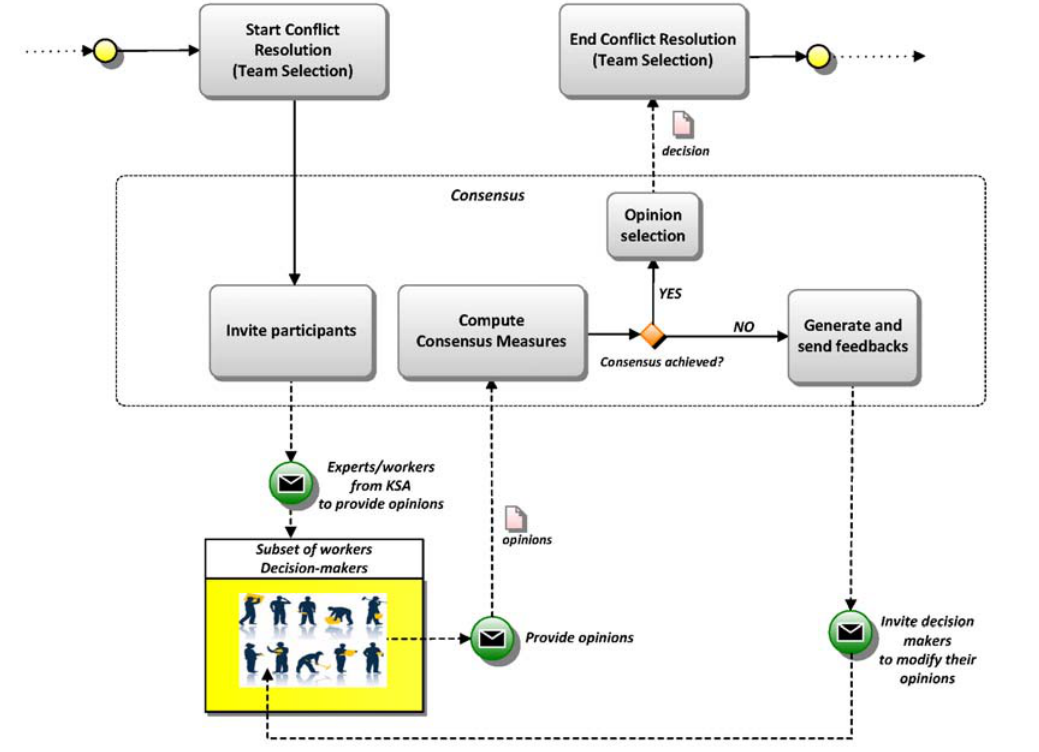
Figure 1. BPMN diagram for the proposed approach